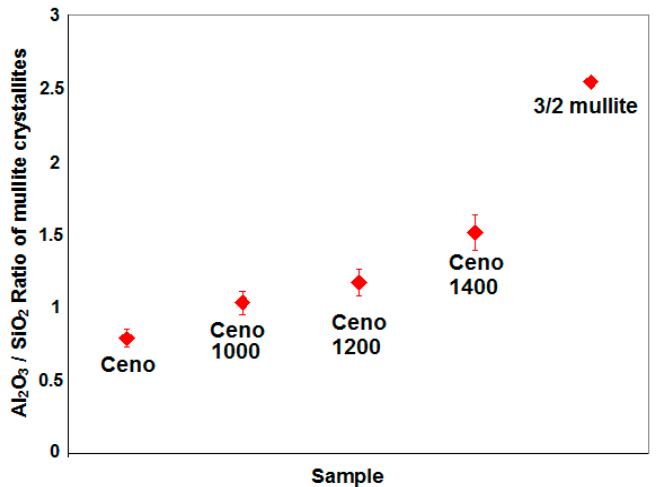
Figure 7. Al 2 O 3 /SiO 2 weight ratio of mullite crystallites in cenosphere samples by FESEM–EDS analysis.